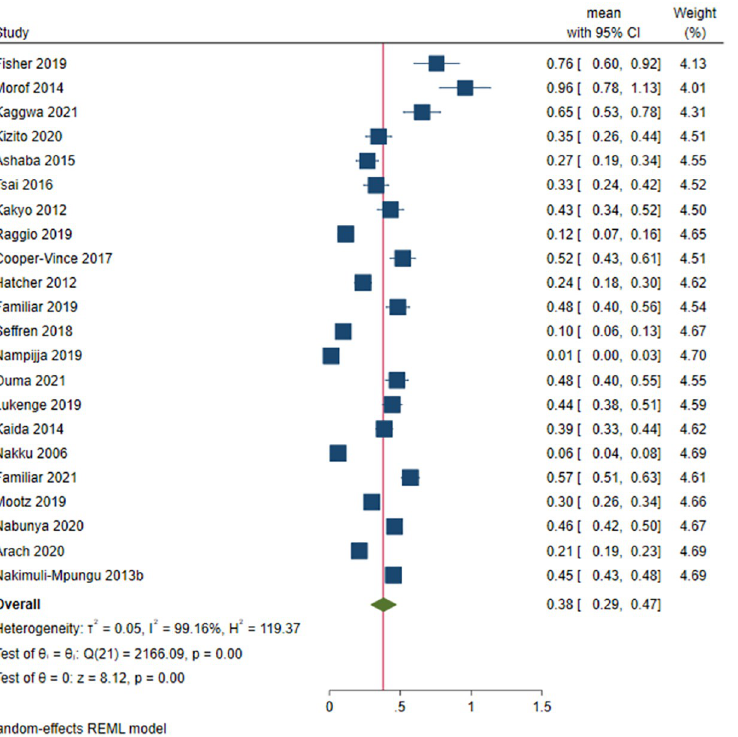
Fig 6. Forest plot on the prevalence of depression among females in